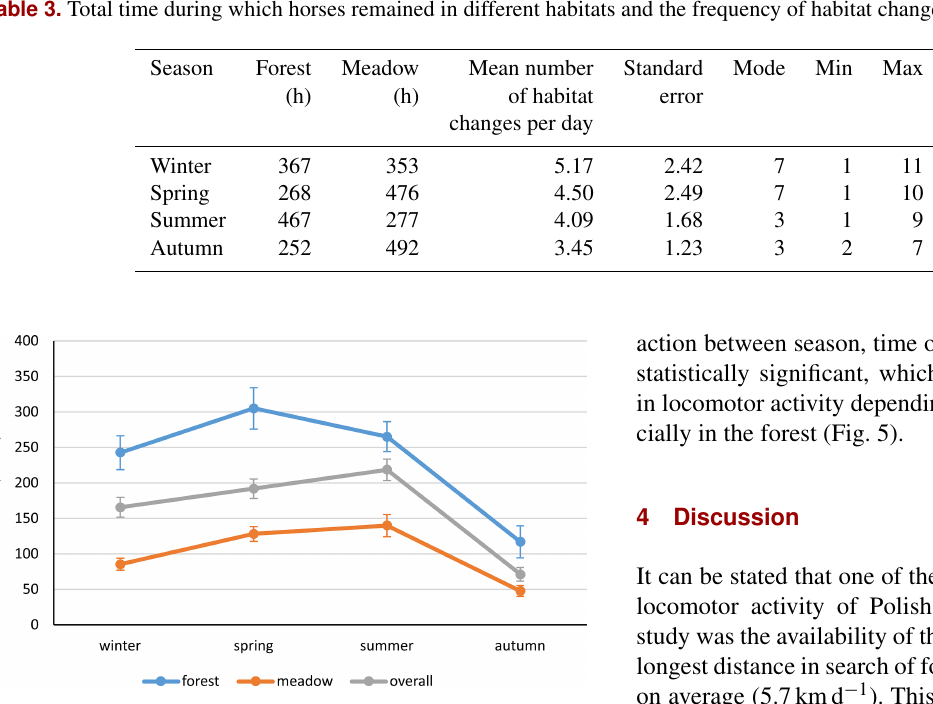
Figure 3. The mean distance (mh − 1 ) travelled by Polish Konik horses during different seasons in both habitats.